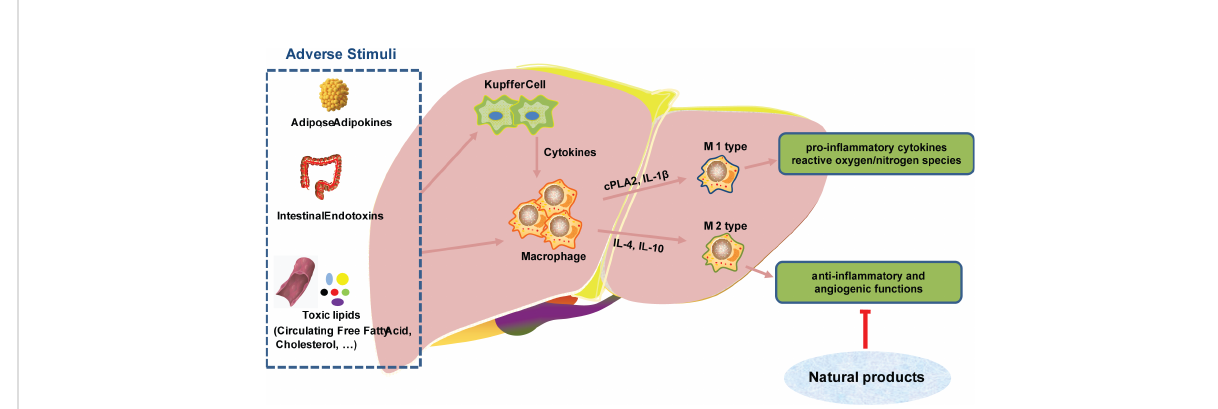
FIGURE 3 Natural products targeting macrophages in the treatment of liver cancer.